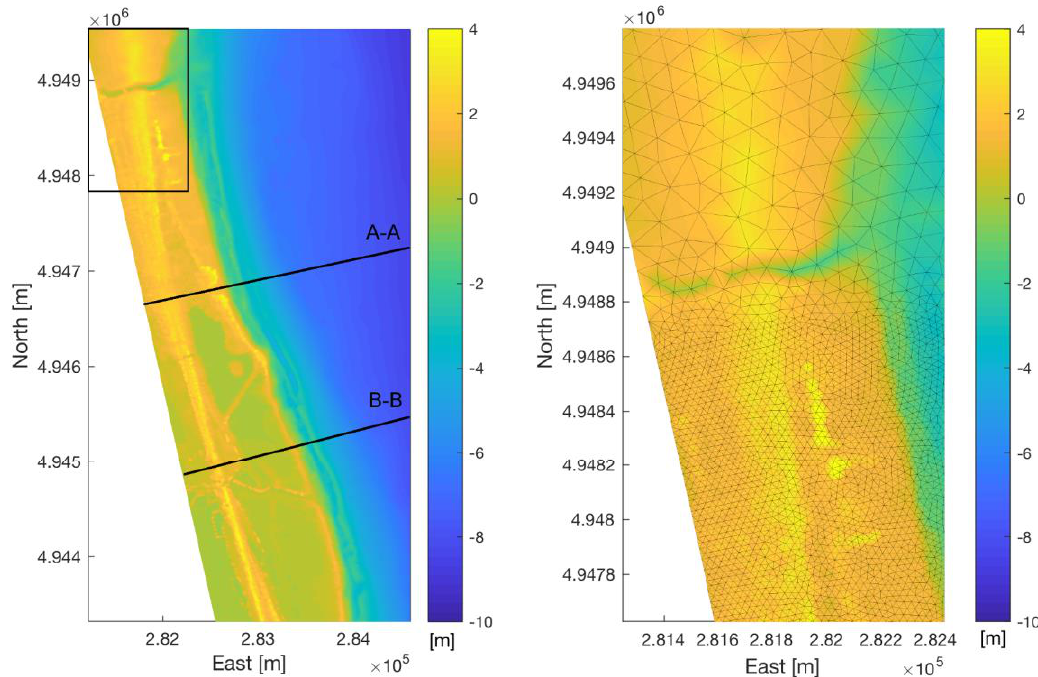
Figure 6. Interpolated bathymetry map in UTM-WGS84 coordinates used for the TELEMAC simulations ( left panel ), as well as the position of the two selected transects A-A and B-B (solid lines). Zoom on the implemented variable density unstructured mesh for the study area (( right panel ) corresponding to the black box in ( left panel )).